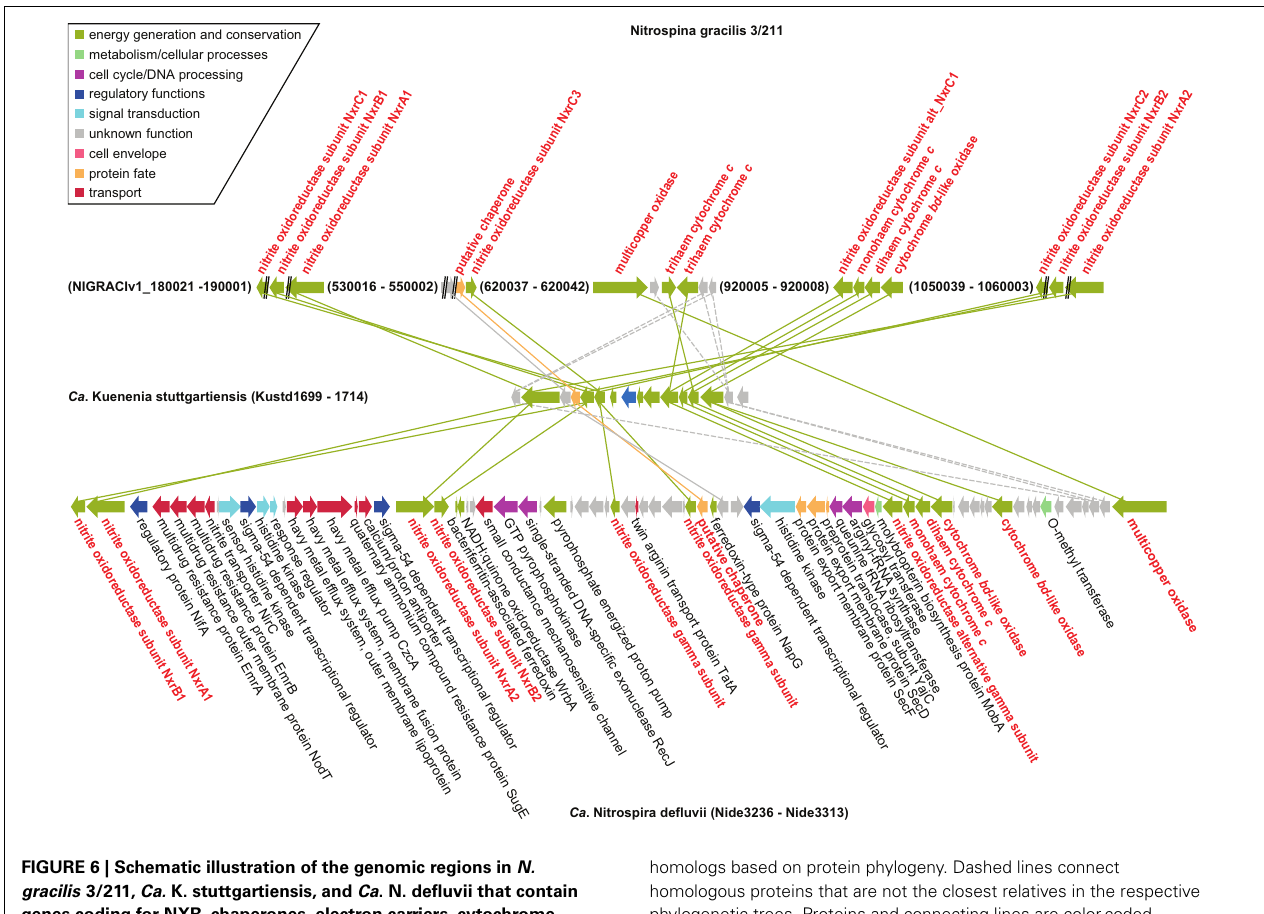
FIGURE 6 | Schematic illustration of the genomic regions in N. gracilis 3/211, Ca. K. stuttgartiensis, and Ca . N. defluvii that contain genes coding for NXR, chaperones, electron carriers, cytochrome bd -like oxidases, multicopper oxidases, and conserved proteins of unknown function. Solid lines indicate proteins that are closest